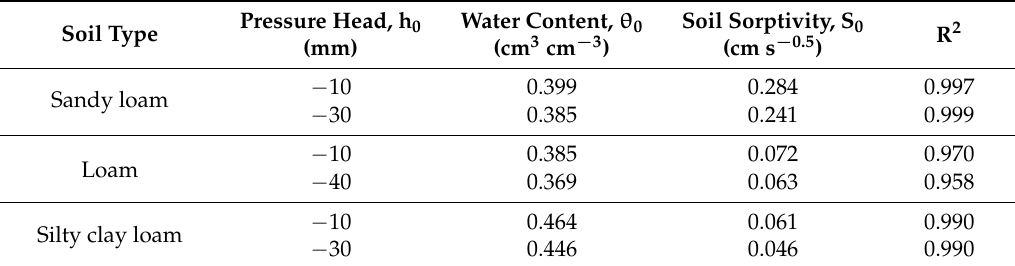
Table 2. One-dimensional infiltration parameters, h 0 , θ 0 , and S 0 , for sandy loam, loam, and silty clay loam soil. R 2 is the coefficient of determination between the experimental infiltration data I 1D fitted curve for S 0